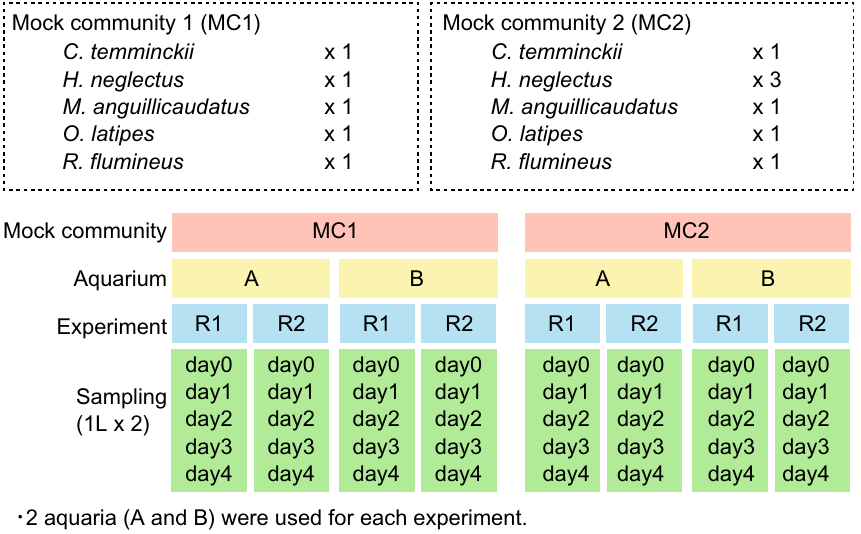
Figure 2. Experimental setup of the aquarium